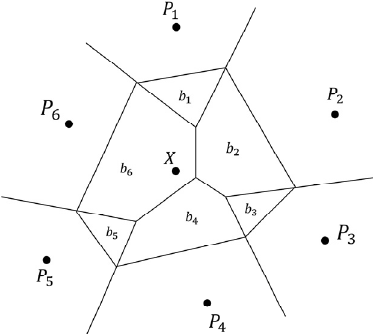
Figure 7. Basic principle diagram of natural neighbor interpolation.